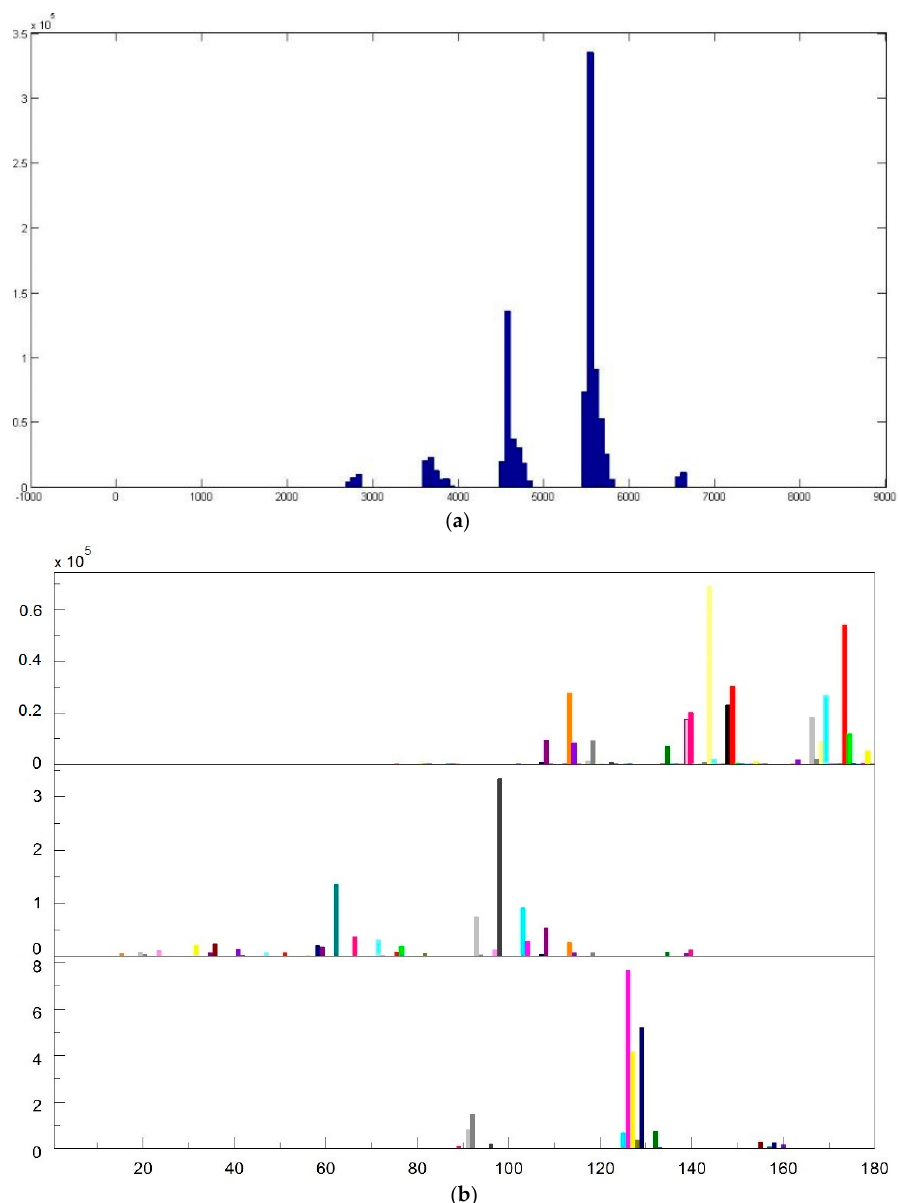
Figure 5. Comparison of the number of histogram bins. ( a ) A typical histogram of a cluster with 8192 bins; ( b ) a trimmed version of a histogram with 176 bins for three clusters.